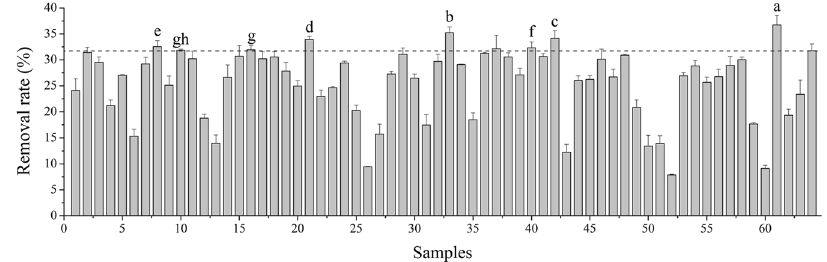
Figure 1. Alkali lignin removal rate (%) of mediums after pretreatment with 64 strains for 96 h at 29 °C. The data presented is average ± standard deviation for triplicate experiments for each fungal